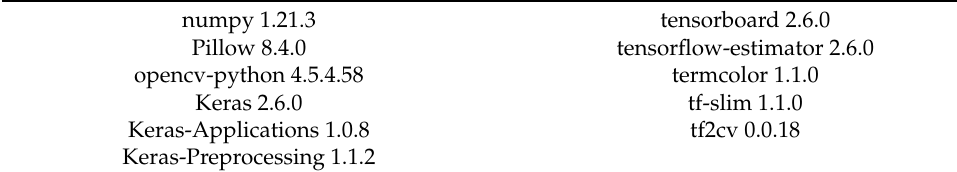
Table A2. Common pip3 package.